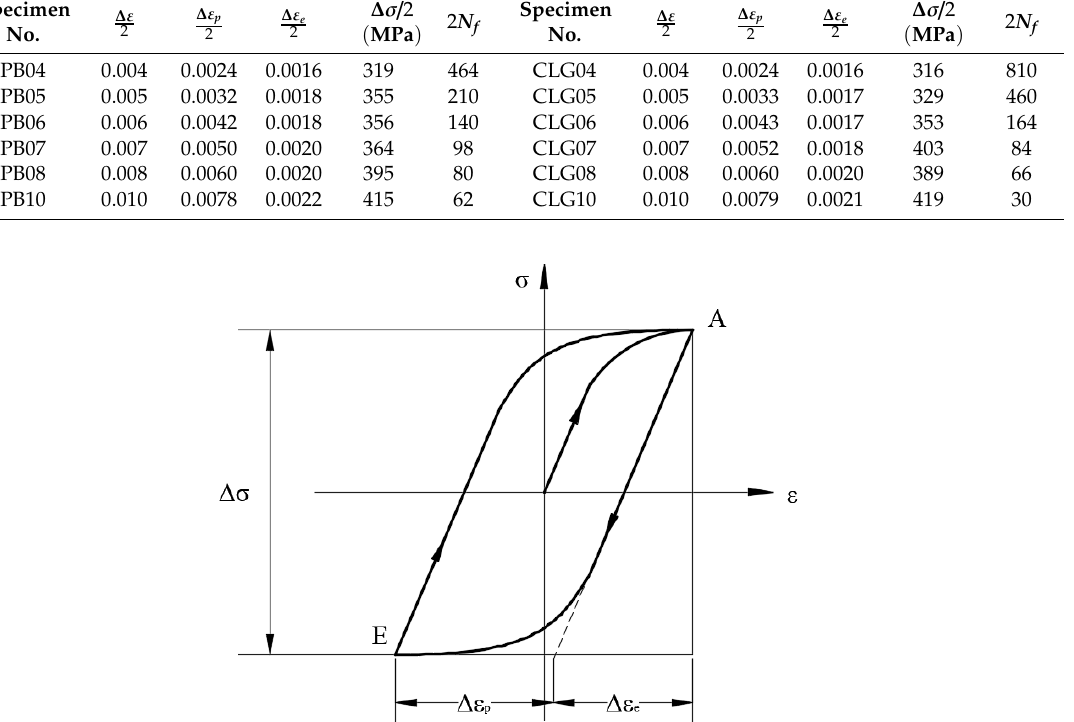
Table 2. Strain amplitude used in the tests and test results.